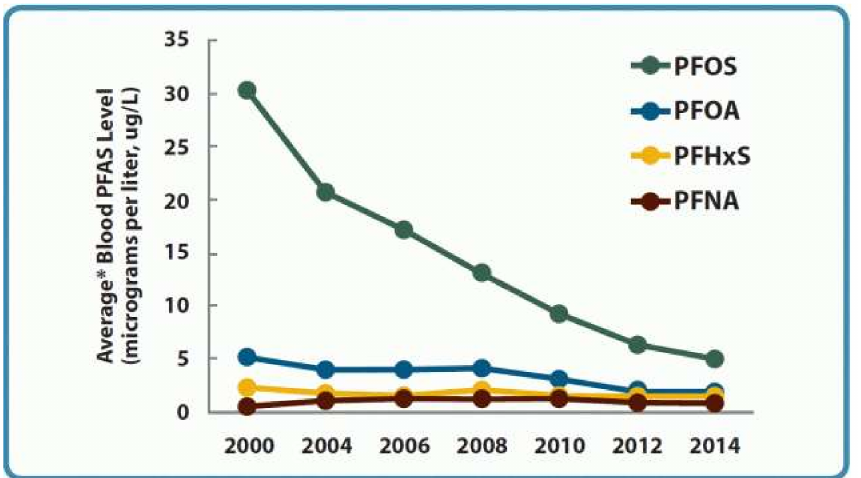
Figure 3. Blood Levels of the Most Common PFAS in People in the United States from 2000–2014. Originally published in Fourth Report on Human Exposure to Environmental Chemicals, Updated Tables, (January 2017). Atlanta, GA: U.S. Department of Health and Human Services (HHS), Centers for Disease Control and Prevention (CDC). This figure is freely available on the agency’s website and its use does not imply endorsement of this manuscript by CDC, HHS, or the United States Government. PFAS (per- and polyfluoroalkyl substances, PFOA (perfluorooctanic acid), PFHxS (perfluorohexane sulfonic acid), PFNA (perfluorononanoic